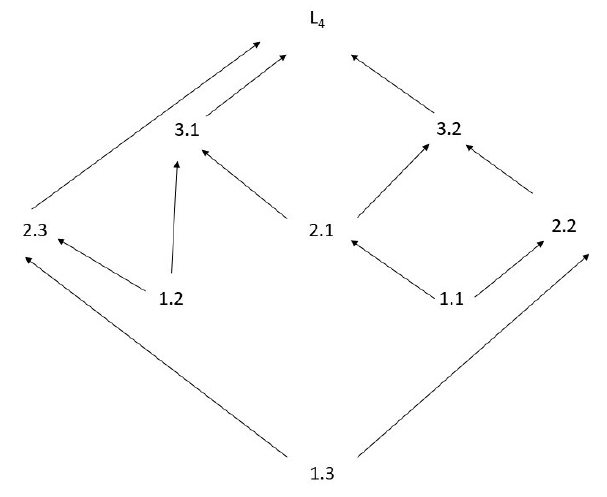
Figure 1. The graph of embedded